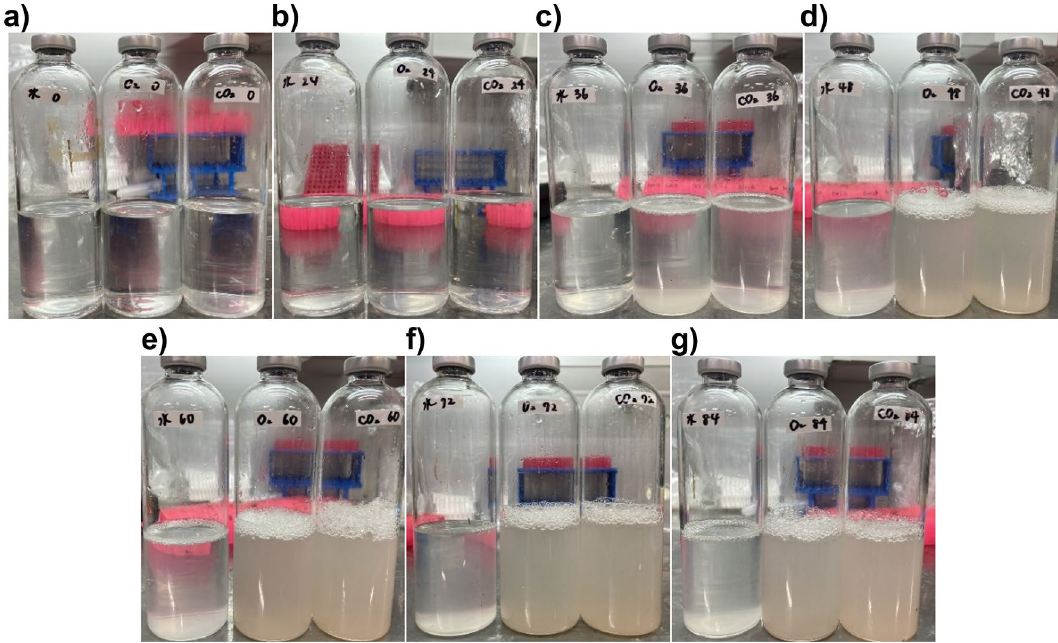
Figure 5. Photo images of culture solution of P . aeruginosa in the Cooper’s medium. Every photo image shows culture solution of P . aeruginosa cultured in from the left, nanobubbles-free medium, oxygen nanobubbles medium and carbon dioxide nanobubbles medium. ( a ) Culture solution just after the start of cultivation. ( b ) Culture solution after 24 h cultivation. ( c ) Culture solution after 36 h cultivation. ( d ) Culture solution after 48 h cultivation. ( e ) Culture solution after 60 h cultivation. ( f ) Culture solution after 72 h cultivation. ( g ) Culture solution after 84 h cultivation.